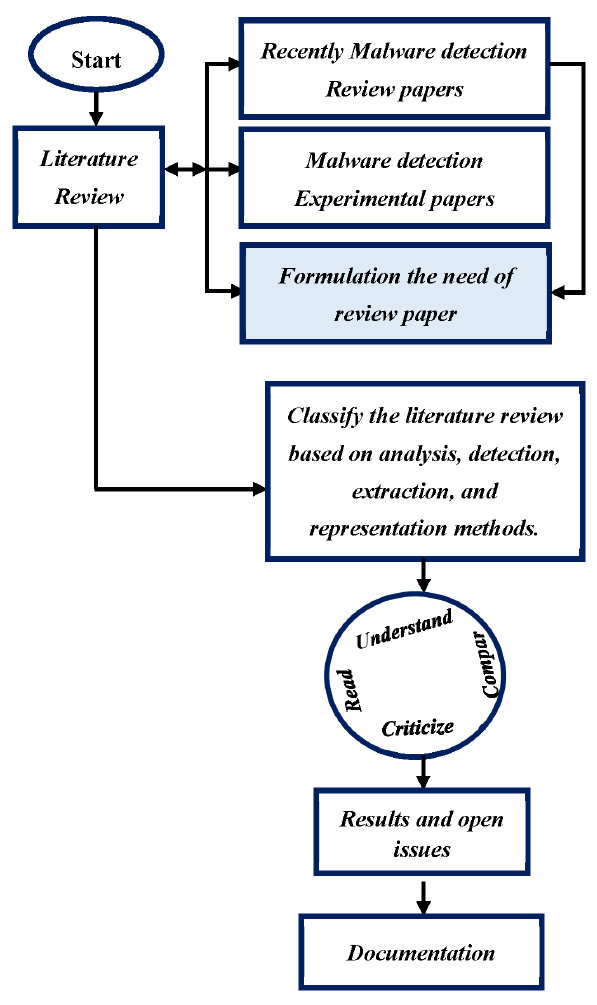
Figure 2. Research Methodology.